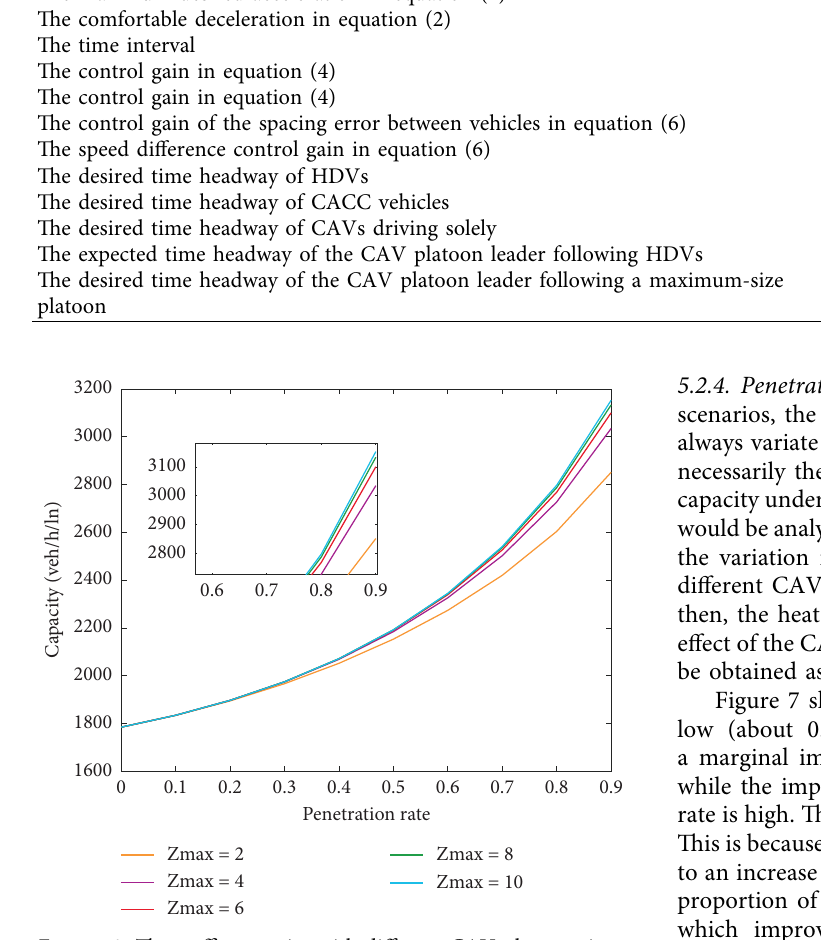
Figure 3: Te trafc capacity with diferent CAV platoon sizes.